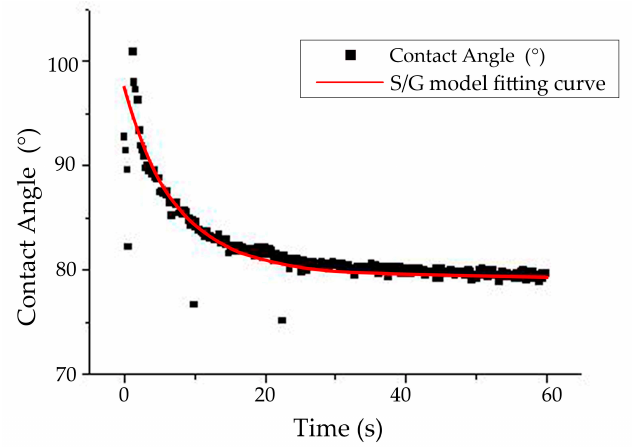
Figure 5. S/G model fitting curve of glycerol contact angle (Sample 1).